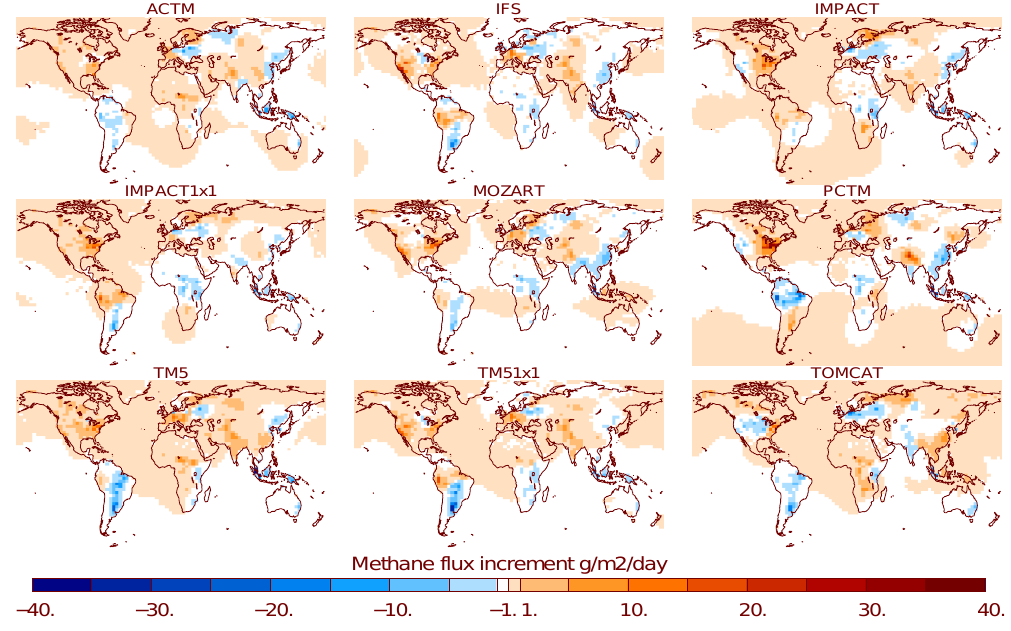
− X target ) at grid box scale for every TransCom